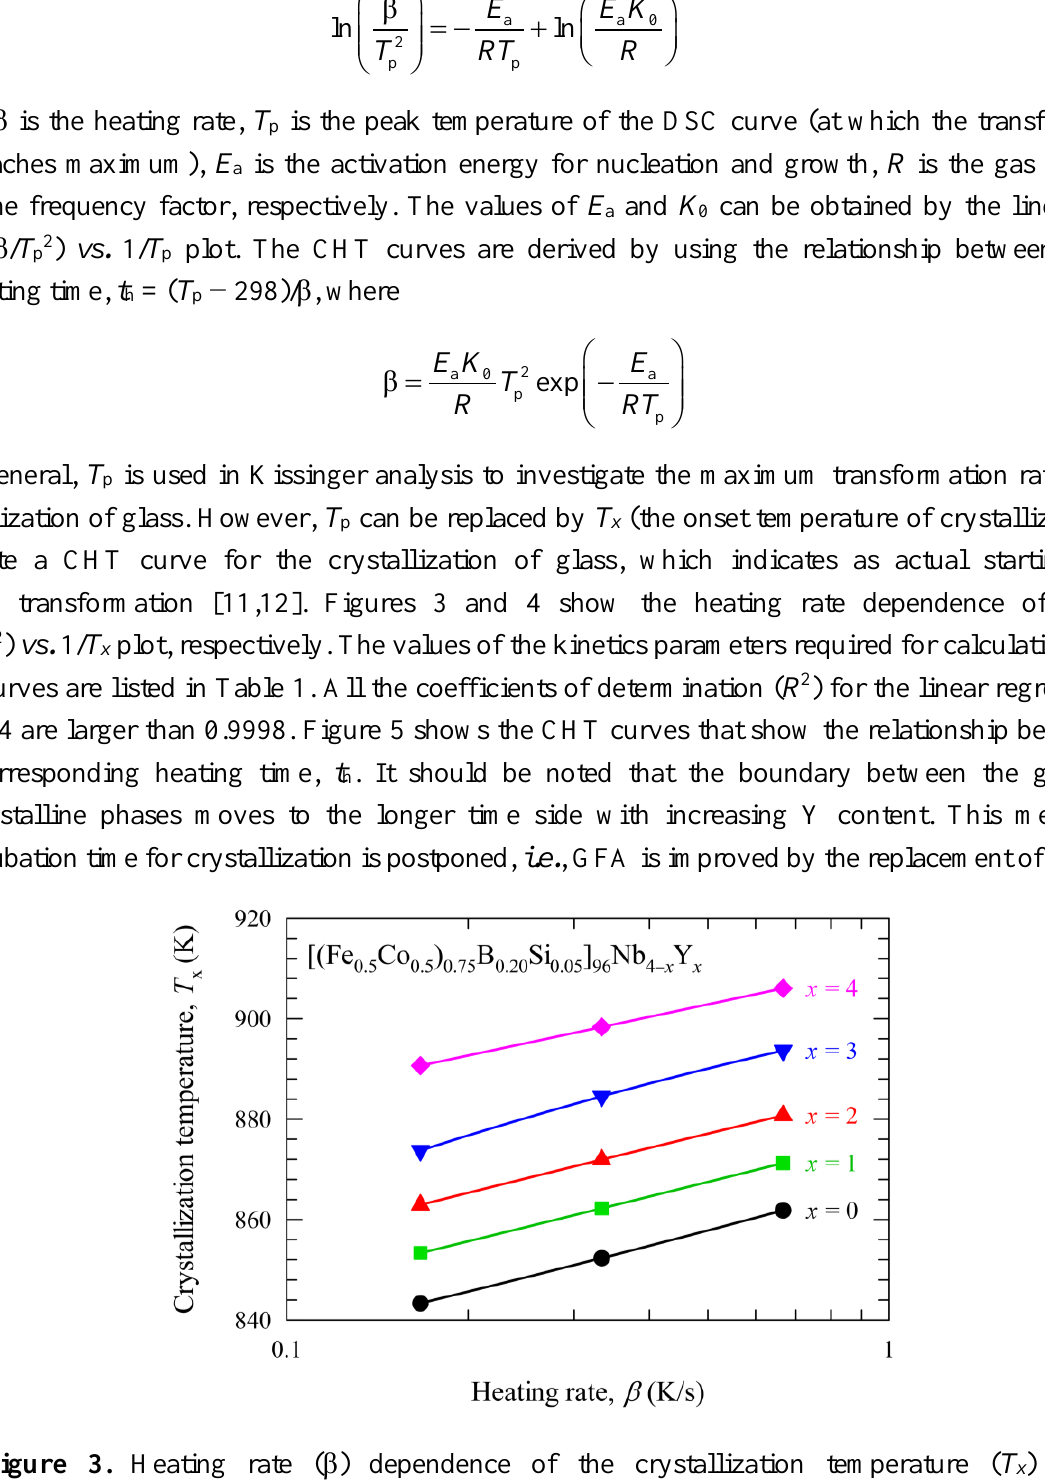
Figure 3. Heating rate (β) dependence of the crystallization temperature ( T x ) of [(Fe 0.5 Co 0.5 ) 0.75 B 0.20 Si 0.05 ] 96 Nb 4− x Y x